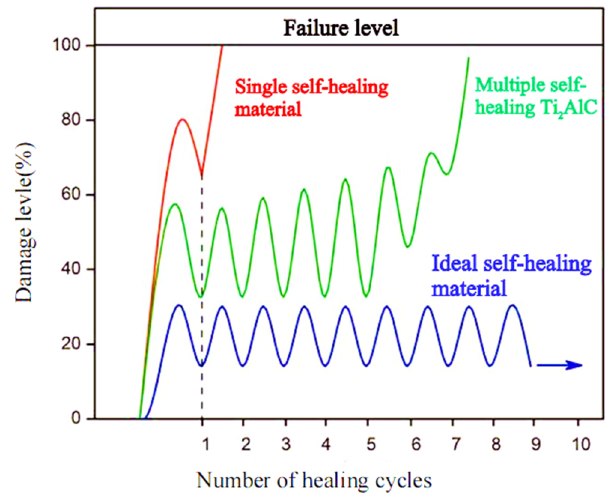
Figure 5. The curves which show the multi-time self-healing phenomenon in the Ti 2 AlC bulk ce- ramic [50]. Red line denotes single self-healing material, green line denotes multiple self-healing Ti2AlC and blue line denotes ideal self-healing material.